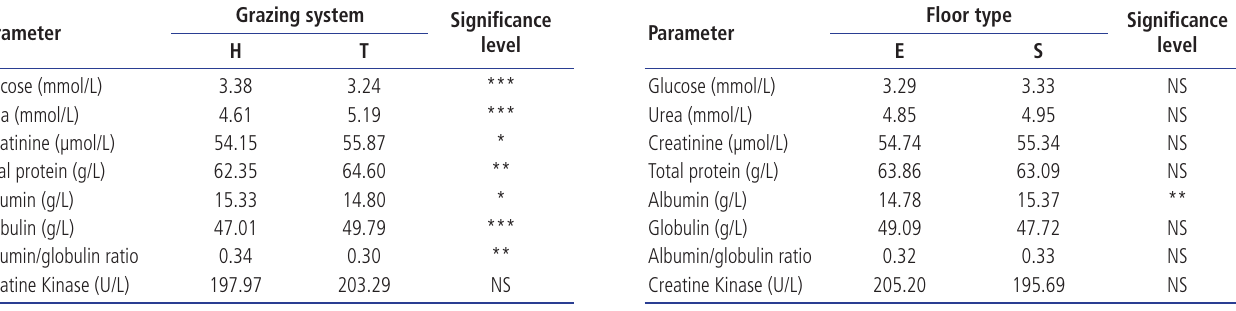
Table 1. Means of blood chemistry parameters of Nguni goats reared under tethering and herding grazing systems Grazing system Significance Parameter